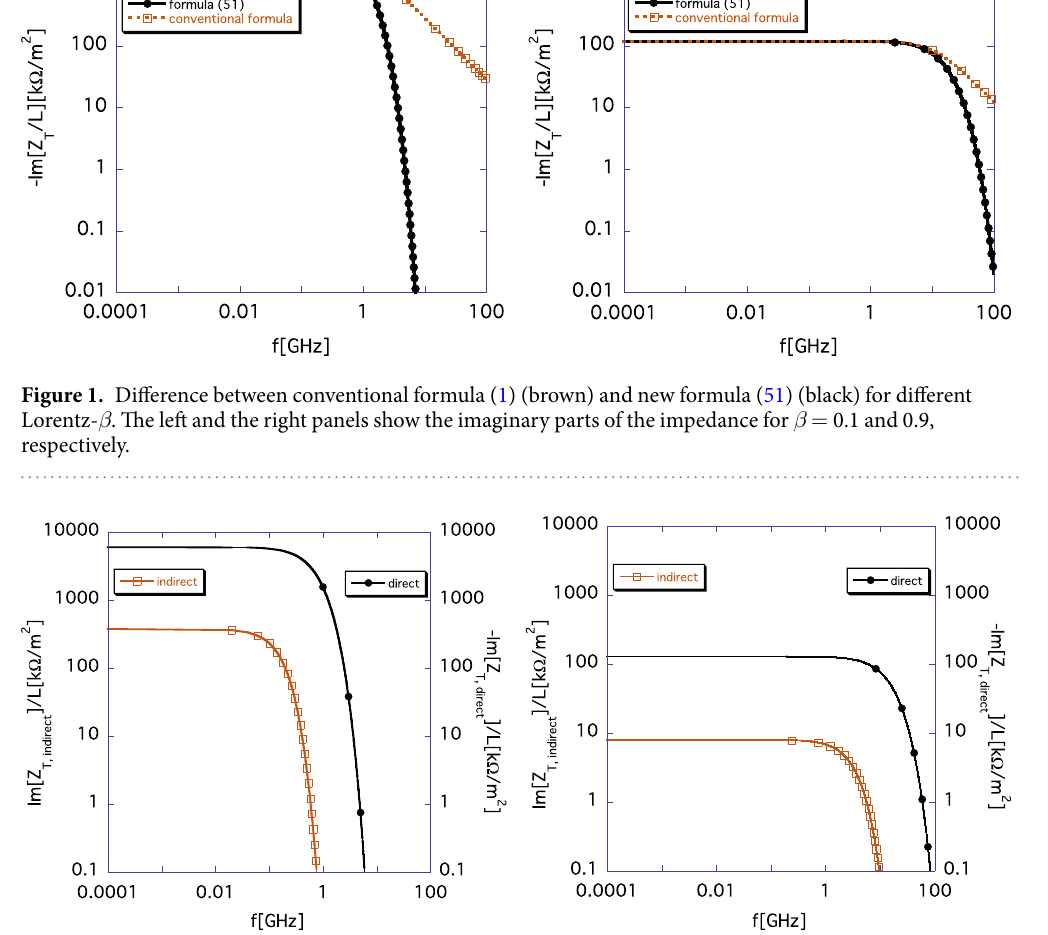
Figure 2. Indirect space-charge impedance Z T , indirect ( ω ) (brown) according to Eq. (53) and direct space-charge impedance Z T , direct ( ω ) (black) according to Eq. (52) among the new formulas (51) for different Lorentz- β . The brown and the black curves are read using the scale markings on the left and the right vertical axes, respectively. The left and the right panels show the results for β = 0.1 and 0.9,